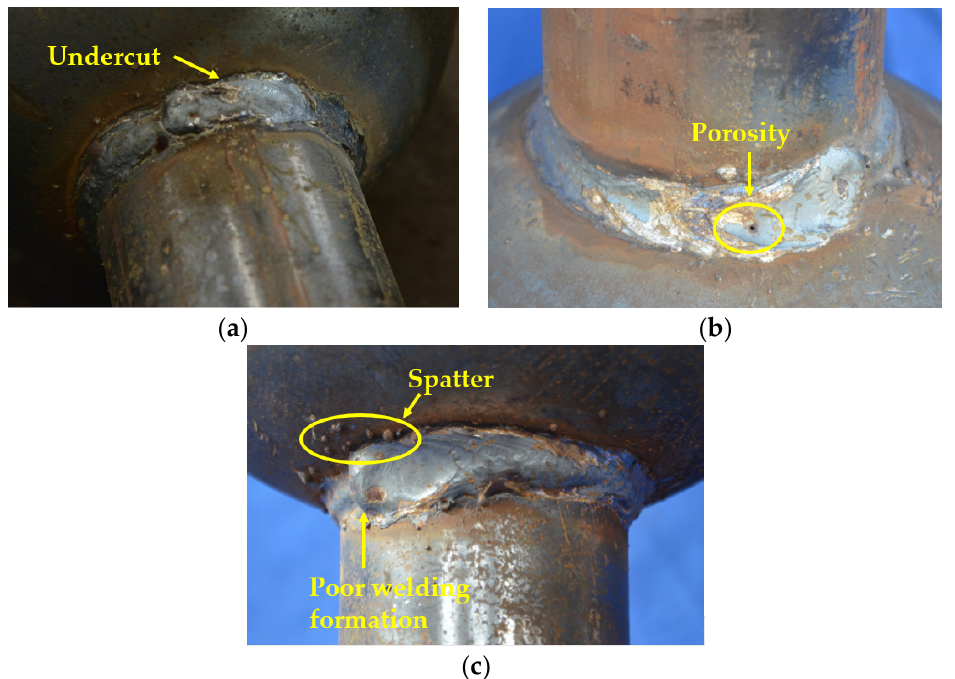
Figure 6. Defects in weld appearance. ( a ) Undercut; ( b ) Porosity; ( c ) Spatter and poor welding for-